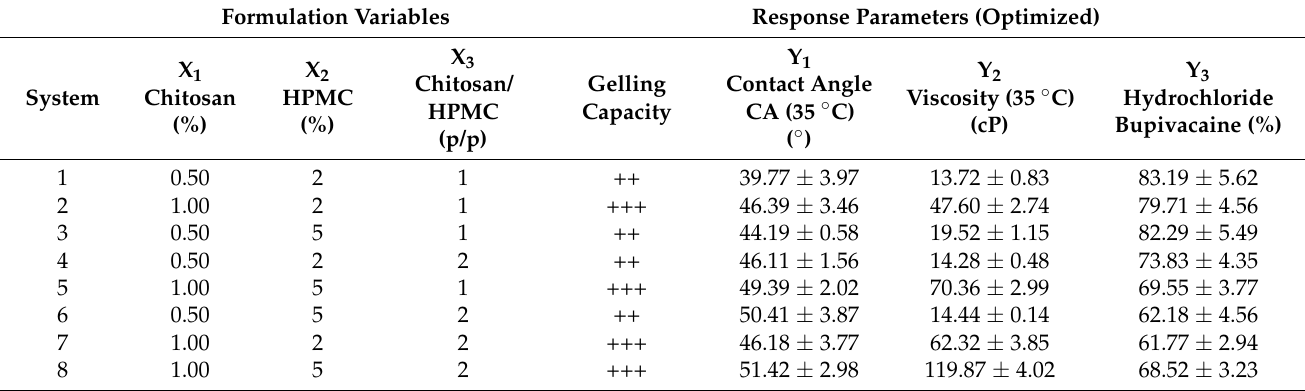
Table 9. Synthesis of the results obtained at the optimization of the formulation of the colloidal systems with in situ gelling, with gels analyzed containing bupivacaine hydrochloride in a polymeric matrix of chitosan and HPMC E 5 LV. Formulation Variables